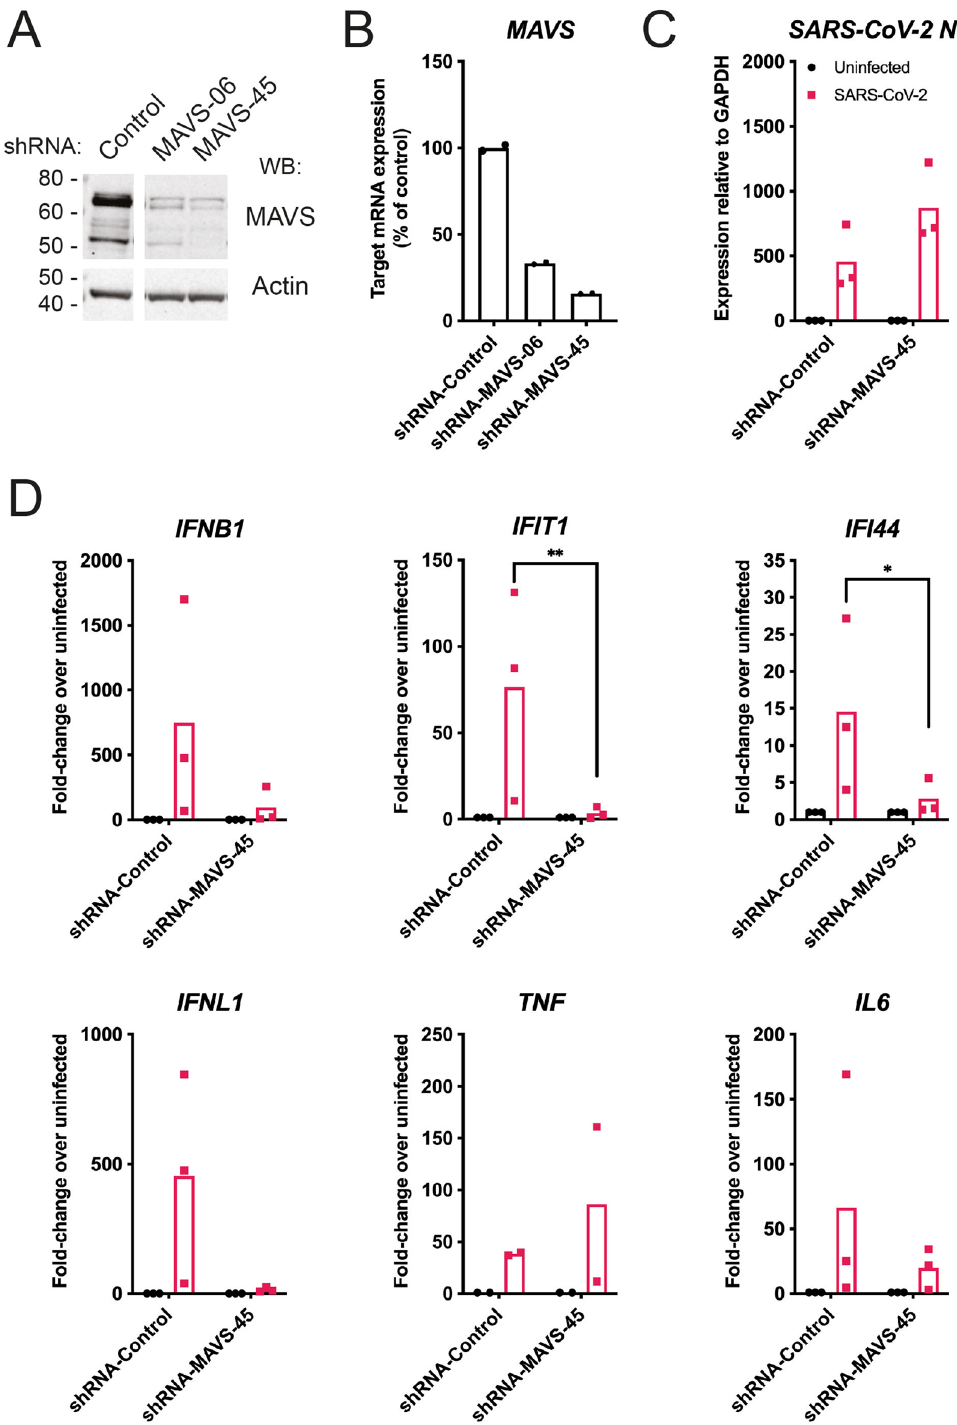
Figure 2. MAVS is required for the type I and III IFN response to SARS-CoV-2. ( A , B ) Calu-3 cells were depleted of MAVS by lentiviral shRNA delivery using two independent shRNAs (shRNA-MAVS-06 and shRNA-MAVS-45). Knockdown efficiency was assessed by western blot ( A ) and RT-qPCR ( B ). The control shRNA targeted GFP, which is absent in Calu-3 cells. See Supplementary Figure 3 for full blots. ( C , D ) Calu-3 cells depleted of MAVS using shRNA-MAVS-45 were infected with SARS-CoV-2 (MOI = 0.1) for 48 h, followed by RNA extraction and RT-qPCR for the indicated transcripts. Data are relative to GAPDH expression. Data in ( A , B ) are representative of two independent biological repeats. Data in ( C , D ) are pooled from 3 independent biological repeats, with bars representing the average. Data were analysed by t-test and significant differences are indicated (** P < 0.01; * P <